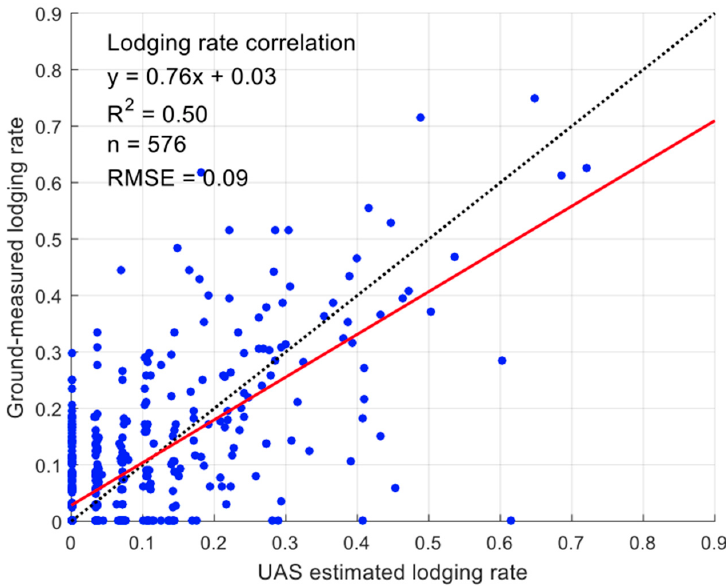
Figure 9. Accuracy assessment of ground-measured lodging rate against UAS-estimated lodging rate.